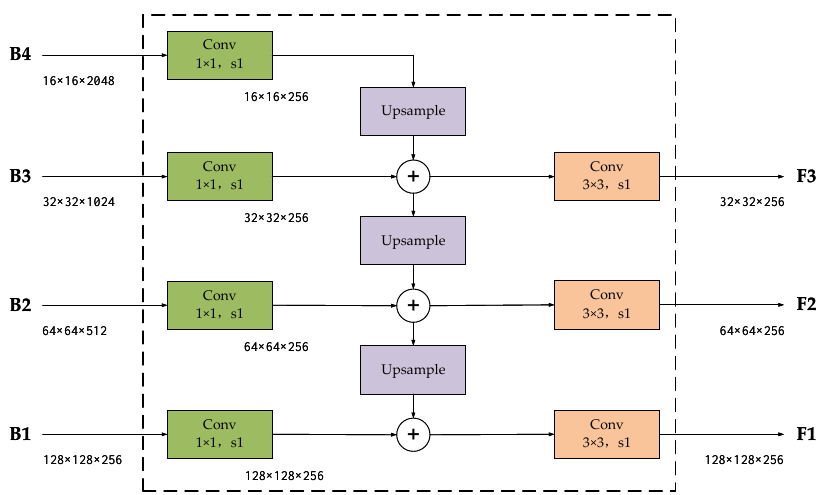
Figure 4. The architecture of FPN in multi-scale Faster-RCNN. Feature maps F1, F2, and F3 are obtained by Feature maps B1, B2, B3, and B4. ‘Conv 1 × 1, s1’ means convolution operation where the size and the stride of the convolution kernel are 1 × 1 and 1, respectively. This representation is also applicable to ‘Conv 3 × 3, s1’. ‘Upsample’ means upsampling operation. The symbol “ ⊕ ” means adding